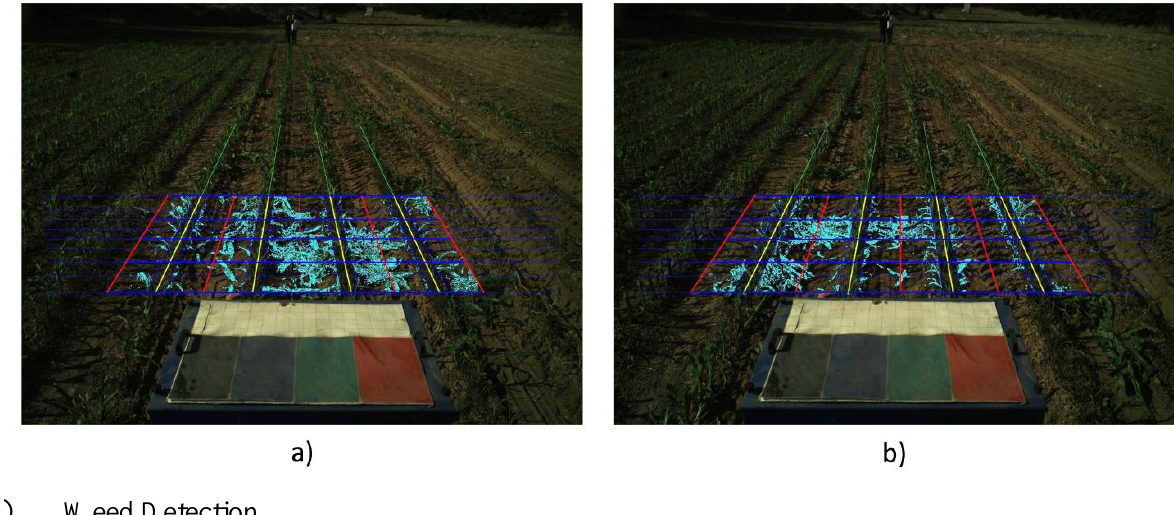
Figure 15. Consecutive images along a sub-path with the detected crop lines (yellow); parallel lines to the left and right crop lines (red); horizontal lines covering 0.25 m in the